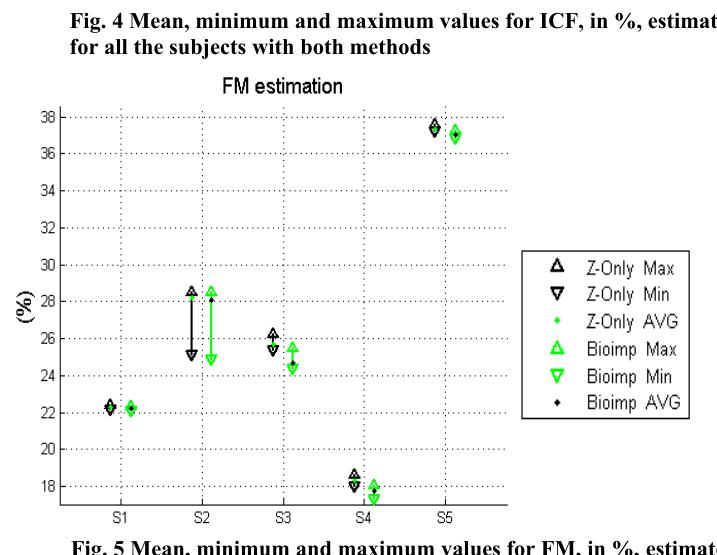
Fig. 5 Mean, minimum and maximum values for FM, in %, estimated for all the subjects with both methods